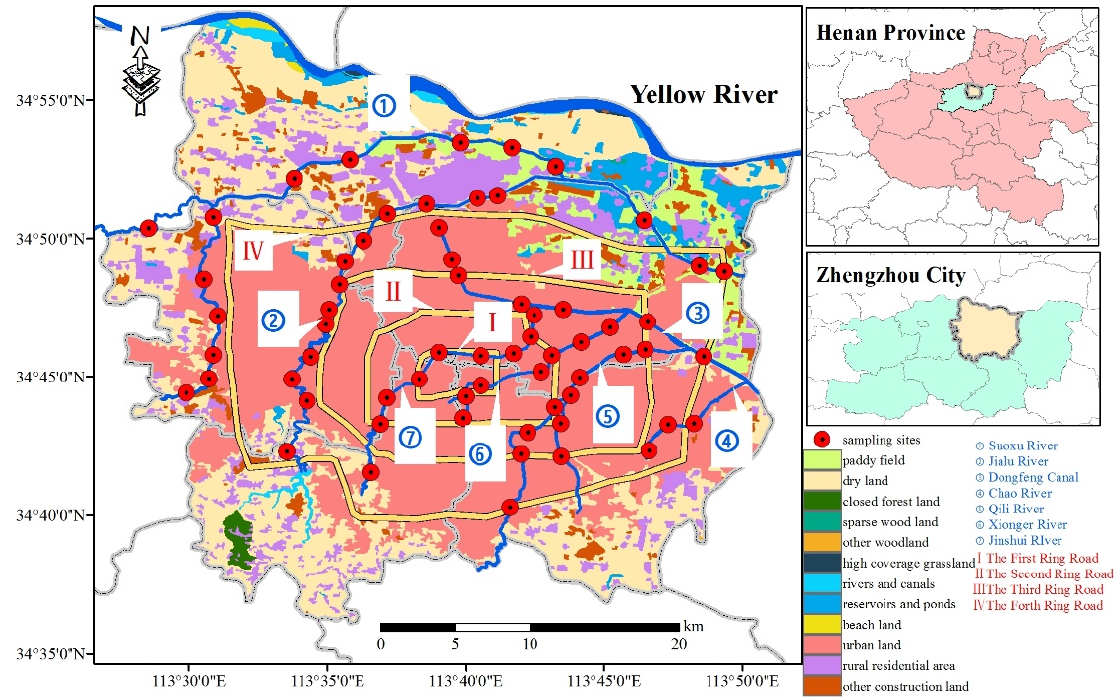
Figure 1. Location of the study area.